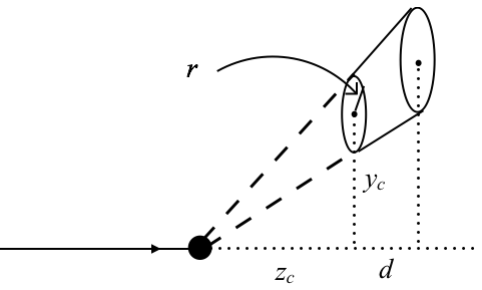
Figure 7. Schematic view of the o(cid:11)-axis con(cid:12)guration implemented in MadDump